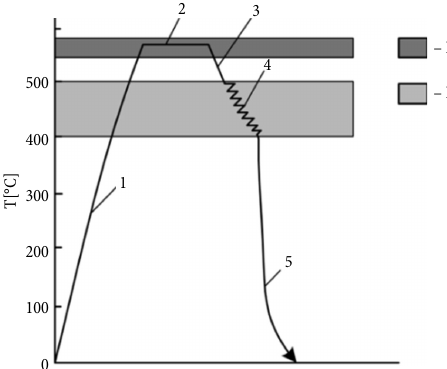
Fig. 7. Independence between duration of sub-cooling and hardness after quenching from different temperatures when the specimens were soaked 30, 45, 60 or 90 minutes (quenching process was followed by artificial ageing at 160 °C for 16 hours)